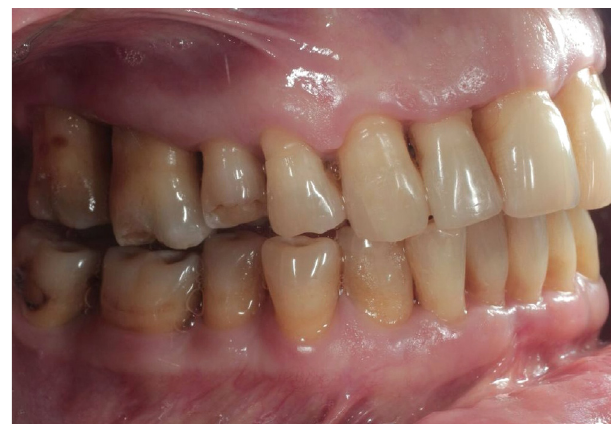
Fig. 4. 26 months post-orthodontic view. Unsightly diastemas have been closed and overbite reduction has